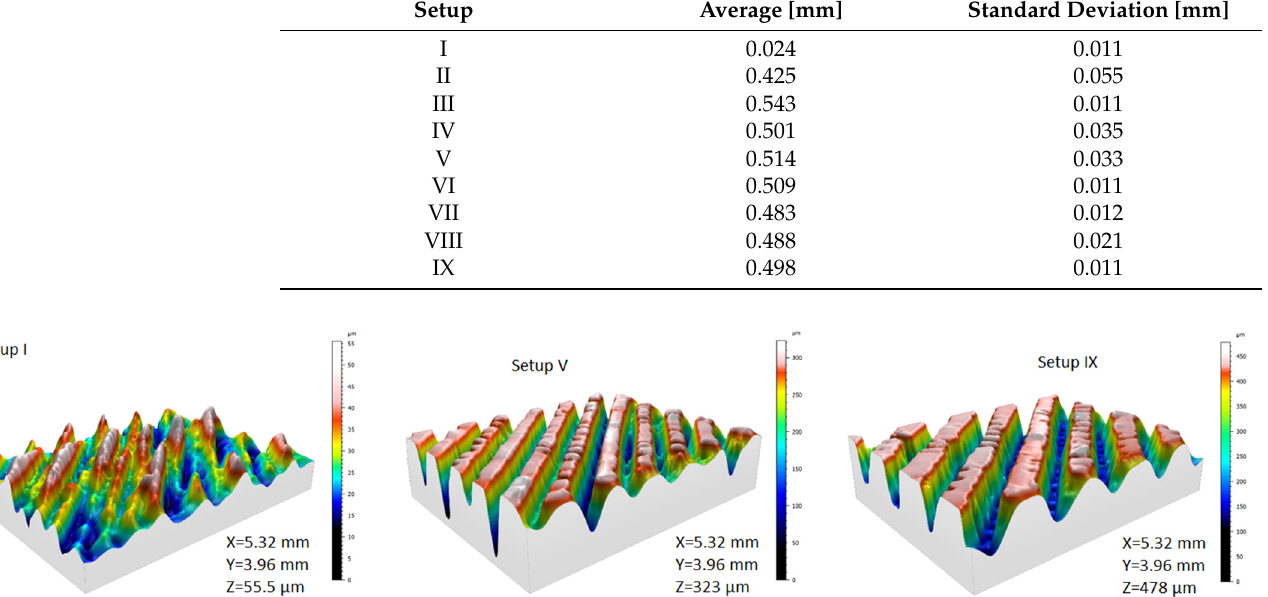
Figure 5. Scanned FDM surfaces for setup I ( left ), setup V ( center ), and setup IX ( right ).